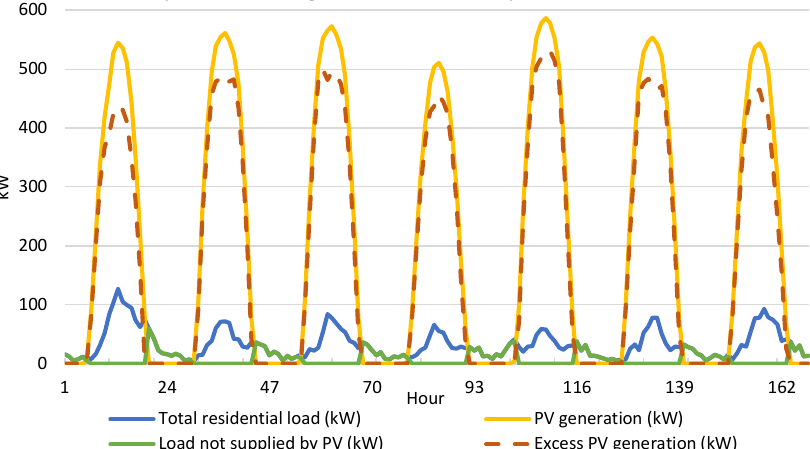
Figure 4. The load profile and PV production for a sample week in summer; excess PV generation is equal to PV generation minus the total load.